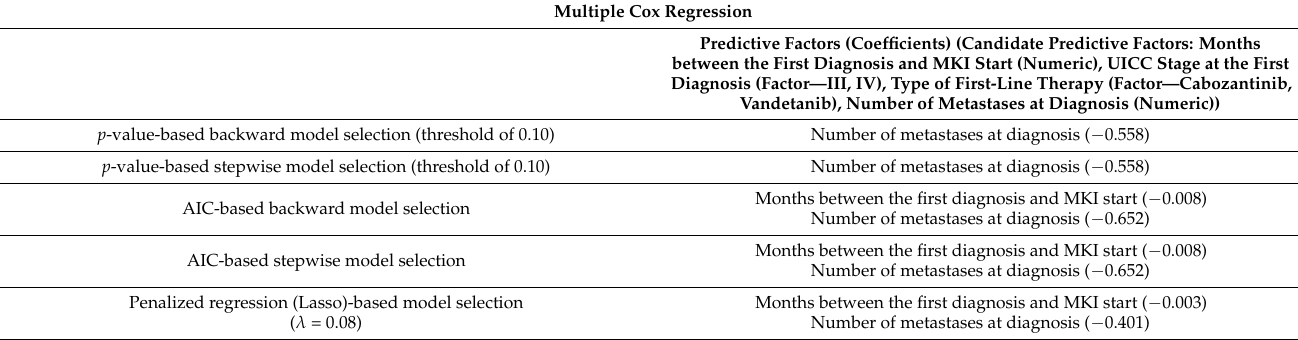
Table 2. Associations of different baseline features with OS in first-line and second-line treatment. Multiple Cox